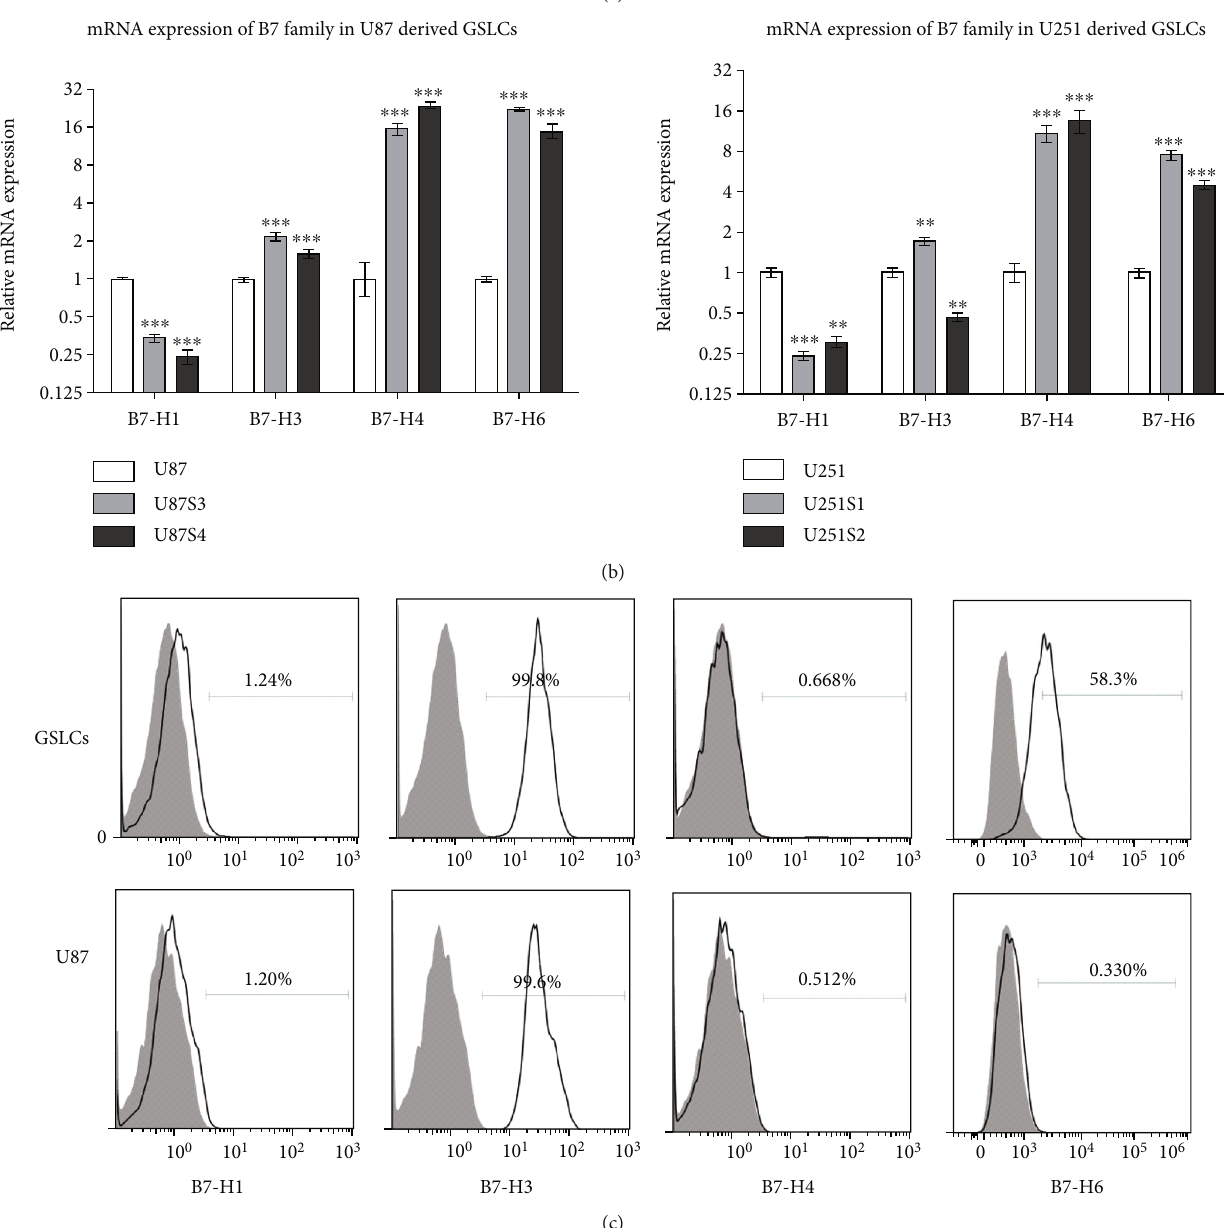
Figure 2: B7 family molecule expression pattern in glioma cell line-derived GSCs. (a) mRNA expression of B7-H1, B7-H3, B7-H4, and B7-H6 in U87-derived GSLCs was detected by PCR after 33 cycles ampli fi cation. (b) mRNA expression of B7-H1, B7-H3, B7-H4, and B7-H6 was detected in two clones of U87- (left) or U251- (right) derived GSLCs and parental cell line by real-time PCR. All data is shown to be signi fi cant ( P < 0 : 005 , n = 3 ) compare to control group. (c) Protein expression of B7-H1, B7-H3, B7-H4, and B7-H6 was detected by fl ow cytometry. Filled histograms represent to isotype controls while open histograms represent to staining groups. Data of (b) were shown as mean ± SD